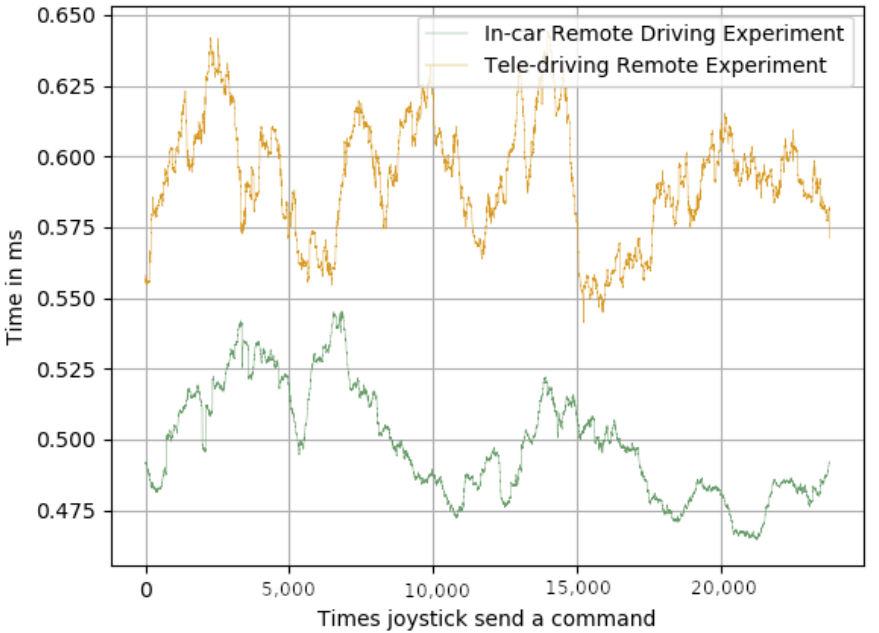
Figure 8. Time in ms from when the command was received until it was sent through the CAN